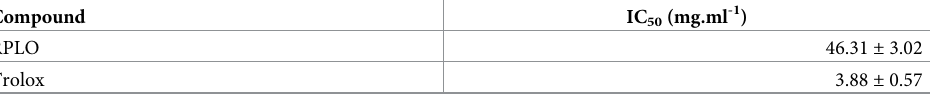
Table 2. Determination of the IC 50 values for RPLO and Trolox, the reference antioxidant, in the direct DPPH radical scavenging